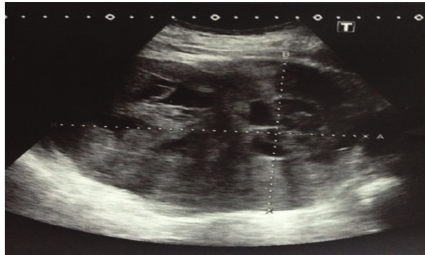
Figure 1: The 150 × 140 × 130mm (RL × AP × KK) mass in left adrenal gland in abdominal ultrasonography.